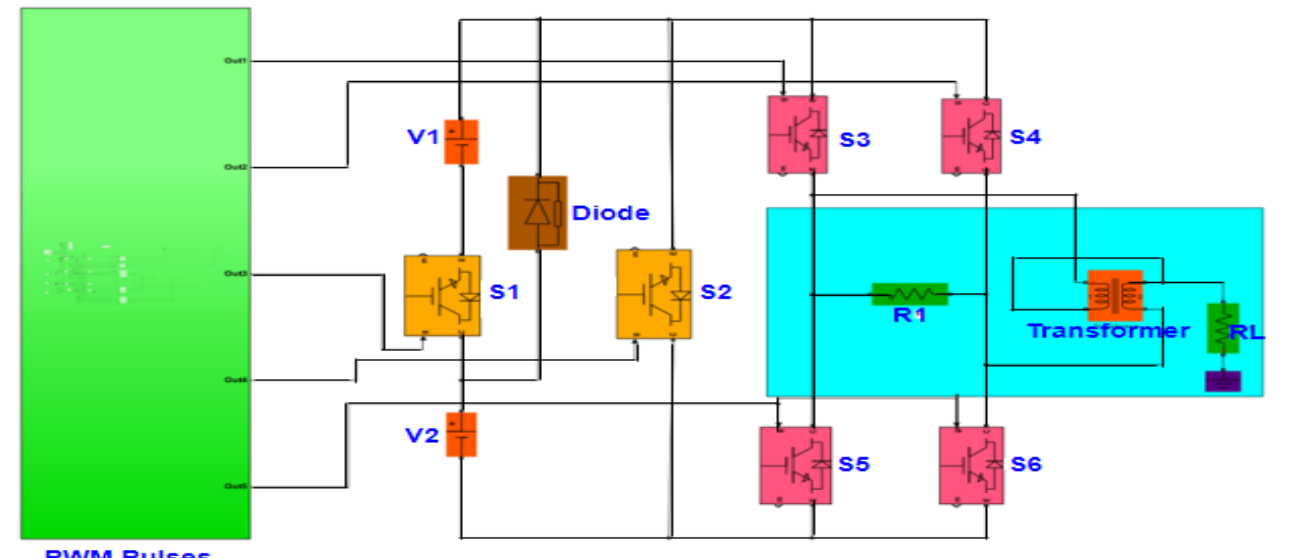
Figure 10. Proposed cascaded H-bridge MLI with 6 switches. Table 5. Switching states of proposed multilevel